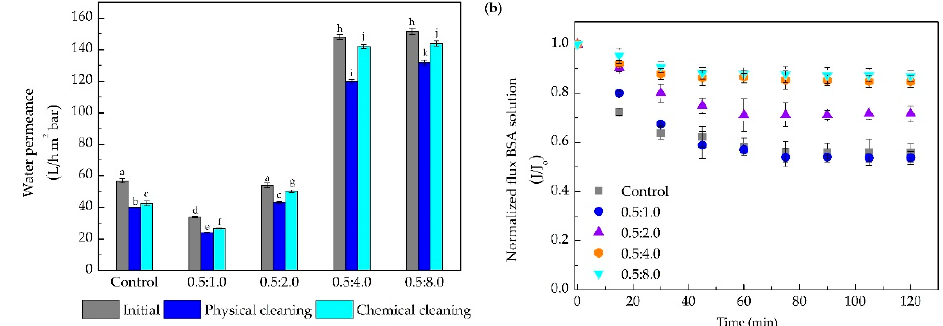
Figure 7. Performance of the control and modified membranes with different concentrations of DA and PEI (0.5:1.0, 0.5:2.0, 0.5:4.0, and, 0.5:8.0 mg mL − 1 ) in the permeation of BSA solution (2.5 g L − 1 ). ( a ) Water permeance before the protein filtration (initial) and after the physical and chemical cleaning. ( b ) Normalized permeate flux of the BSA solution. Bars with different letters show a statistical difference ( p < 0.05).